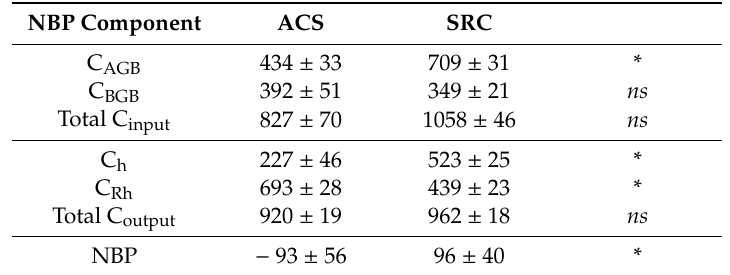
Table 5. Annual NBP components in the two systems (g C m − 2 year − 1 , average ± SE; ACS: Alley Cropping System; and SRC: Short Rotation Coppice system). The values for aboveground biomass (C AGB ), belowground biomass (C BGB ), carbon harvested (C h ), heterotrophic respiration (C Rh ) and the resulting net biome production (NBP) are reported. The asterisks represent significative di ff erences in the C content between the investigated systems ( ns : not significative; *: p <